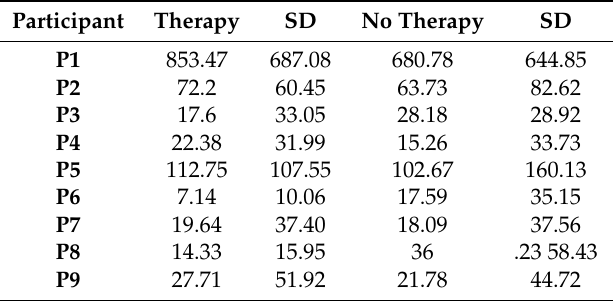
Table 2. Average number of steps between 1:30 and 5:30 pm on days when therapy sessions were held and days with no therapy.